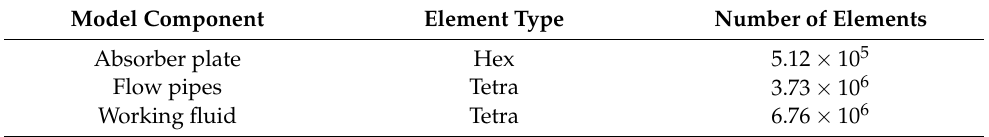
Table 1. Mesh parameters for the solar collector absorber system.